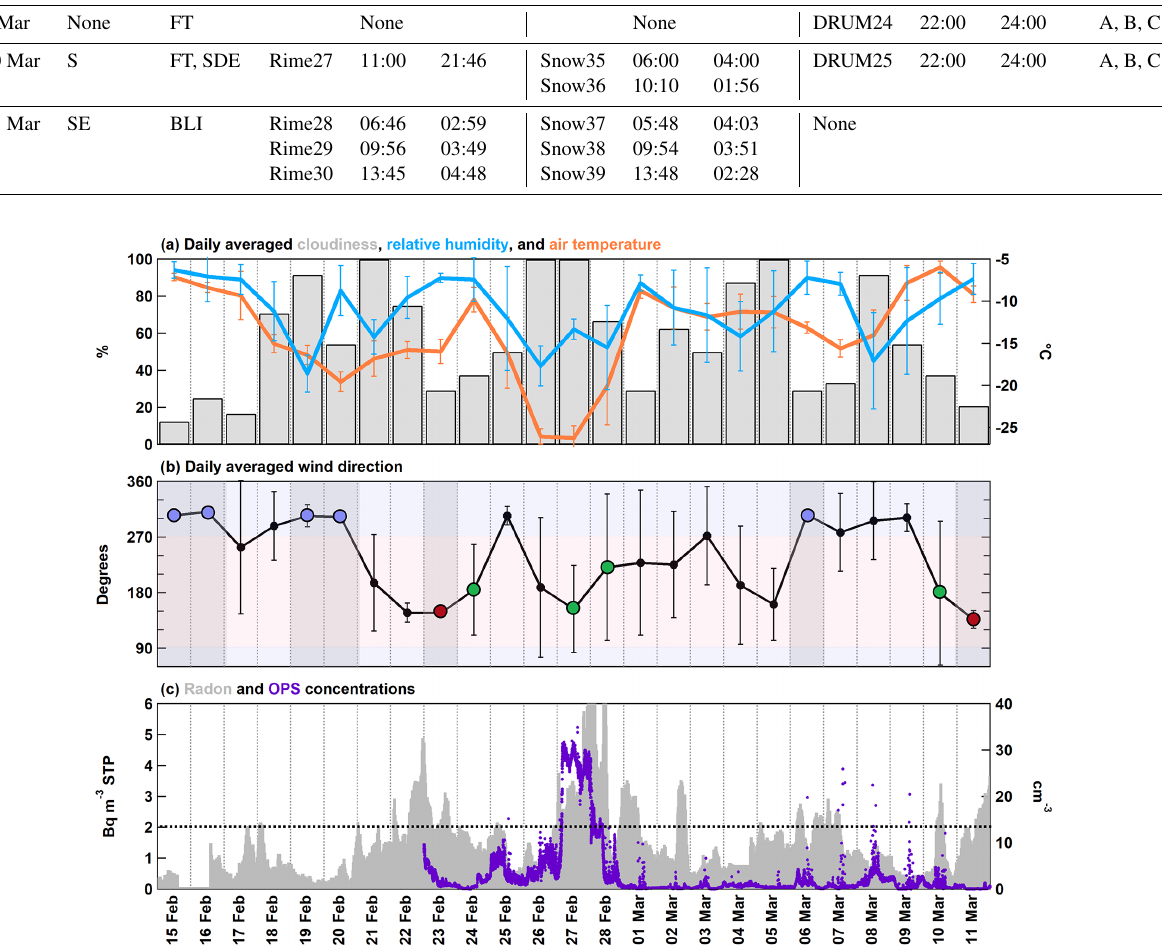
Figure 1. Daily averaged meteorological data at JFJ from INCAS, including (a) percentage of cloudiness in the vertical profile over JFJ as per the estimation by Herrmann et al. (2015), station relative humidity (%), and station air temperature ( ◦ C) and (b) station wind direction. The background of (b) is shaded horizontally by north (light blue) or south (light red) directions. Additionally, days with combined aerosol, cloud rime, and snow collections are vertically shaded grey. Blue and red markers for wind direction represent case study storm days that were entirely northwesterly or southeasterly, respectively. Green markers represent predominantly southerly days that were classified as Saharan dust events (SDEs) or heavy boundary layer influence days. (c) Time series of radon ( 222 Rn) corrected for standard temperature and pressure and OPS particle concentrations. The black dashed line indicates a threshold of 2Bqm − 3 whereby boundary layer intrusion likely occurred at JFJ. OPS data were missing prior to 23 February. Error bars represent standard